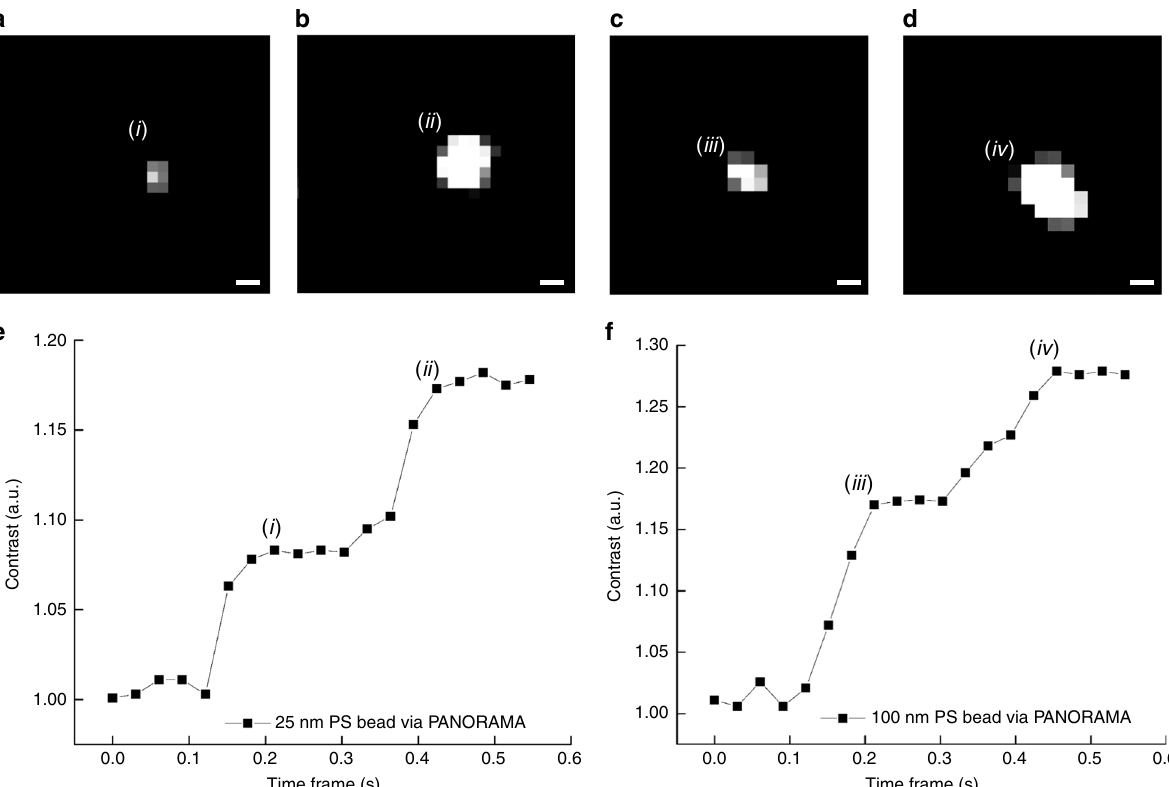
Fig. 6 Particle differentiation in a cluster. a , b Detected 25 nm PS bead at time frame i and ii in ( e ). c , d Detected 100 nm PS bead at time frame iii and iv in ( f ). Dynamic monitoring of IR vs. time where two e 25 nm and f 100 nm PS beads settle at the same location. Scale bar: 390